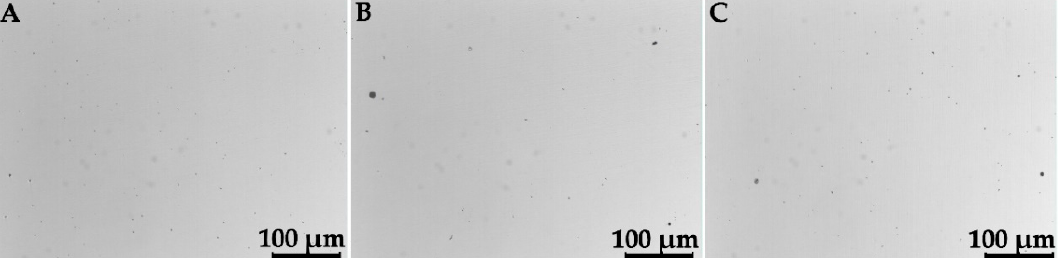
Figure 4. OM images of metallographic sections of Co–Cr–Mo specimens of the X ( A ), Y ( B ), and XY ( C ) groups.